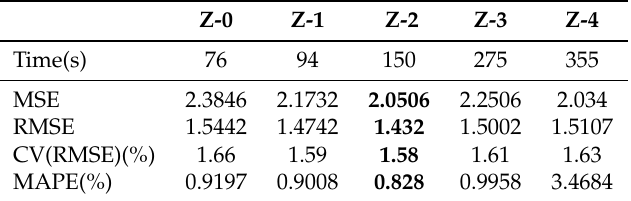
Table 2. Summary of accuracy metrics for RNN LSTM model forecasting: Zurich.